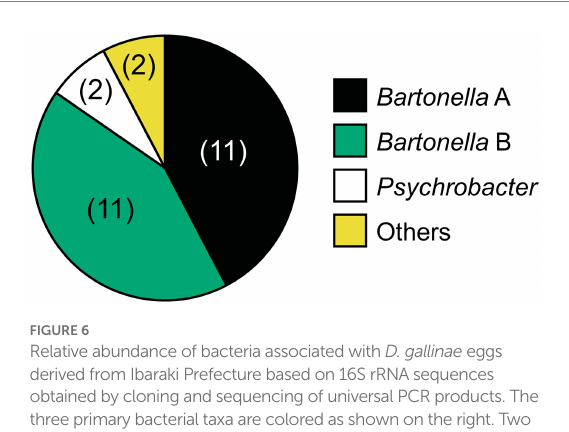
FIGURE 6 Relative abundance of bacteria associated with D. gallinae eggs derived from Ibaraki Prefecture based on 16S rRNA sequences obtained by cloning and sequencing of universal PCR products. The three primary bacterial taxa are colored as shown on the right. Two clones ( Staphylococcus and Clostridium ) are indicated with yellow. The number of clones (among 26 clones) is shown in